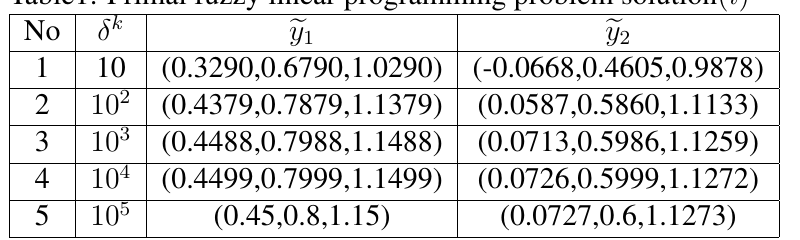
Table1: Primal fuzzy linear programming problem solution ( i )